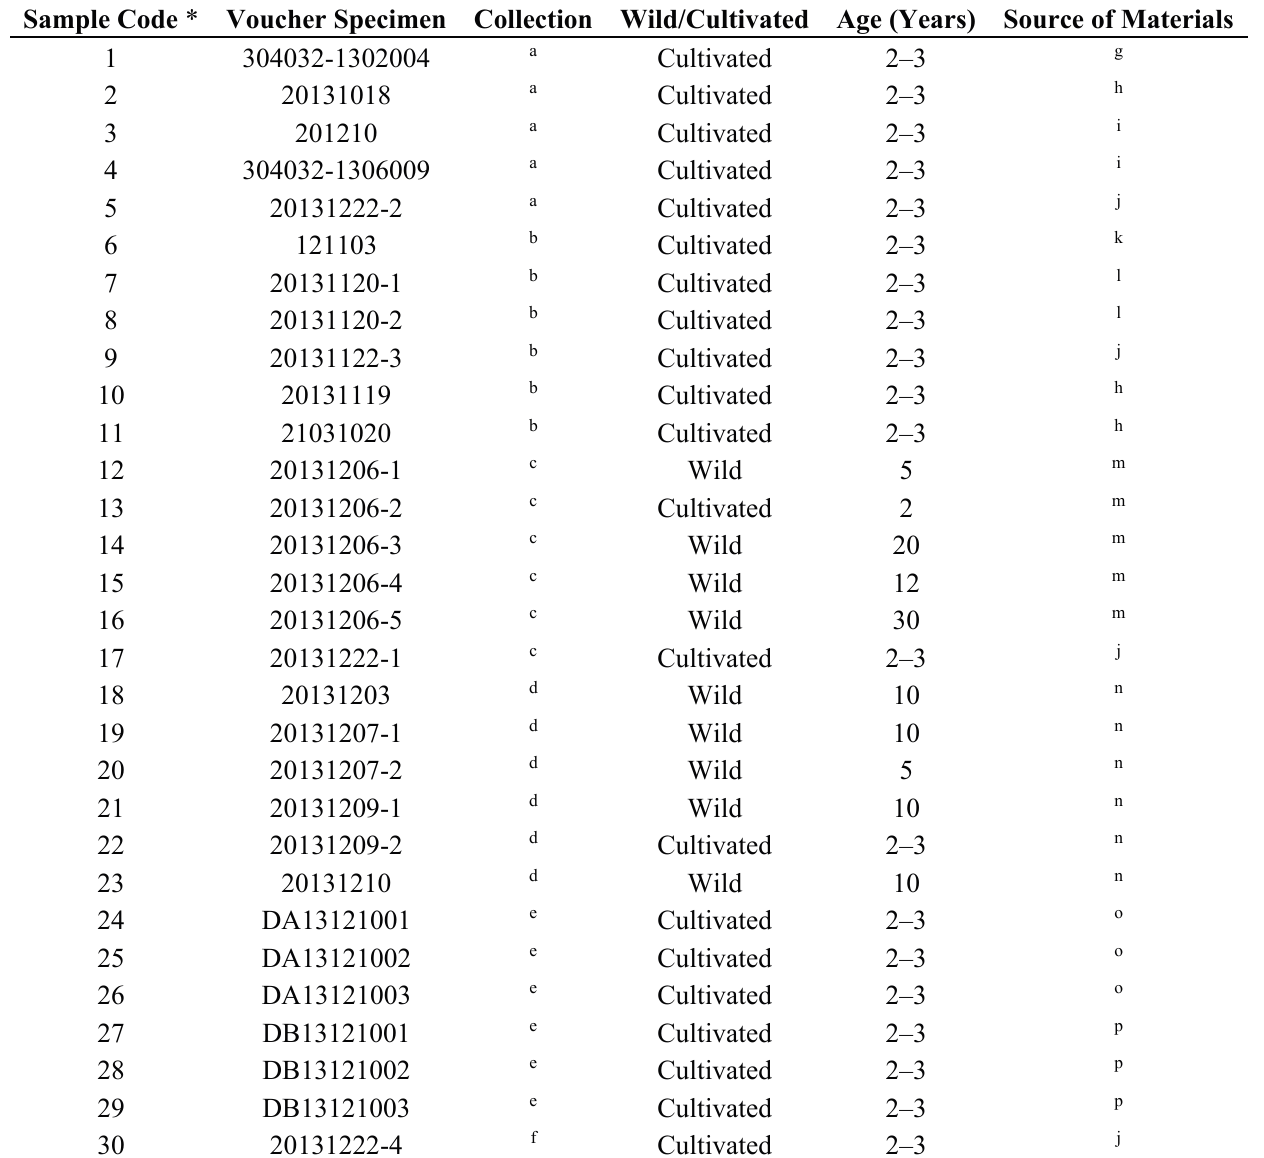
Table 2. Sample information of Astragalus roots evaluated in this